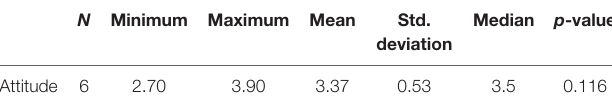
TABLE 11 | Mean and median scores of teachers’ attitude. N Minimum Maximum Mean Std. Attitude